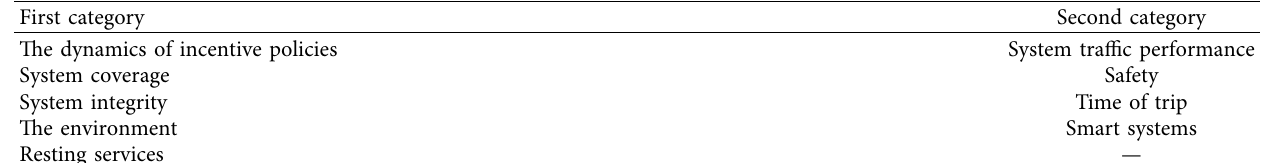
Table 4: Classification of indicators based on rotational analysis.